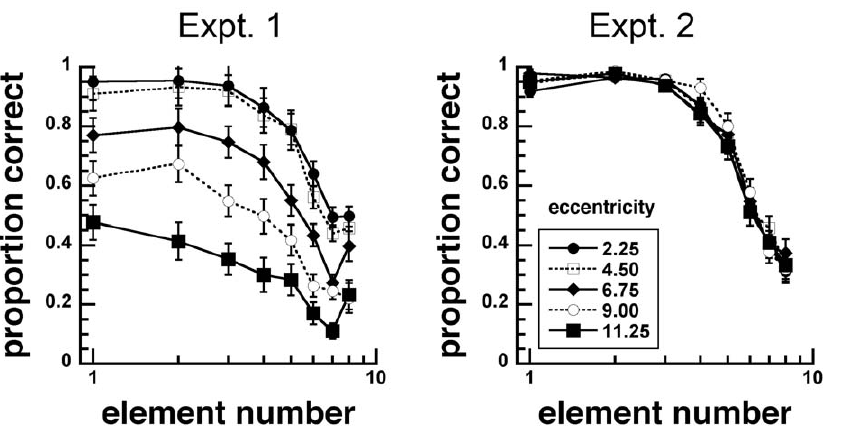
Figure 2. Proportion correct as a function of element number for stimuli with unscaled (Experiment 1) and scaled (Experiment 2) sizes. Enumeration errors increased as viewing eccentricity increased in Experiment 1, but not in Experiment 2.